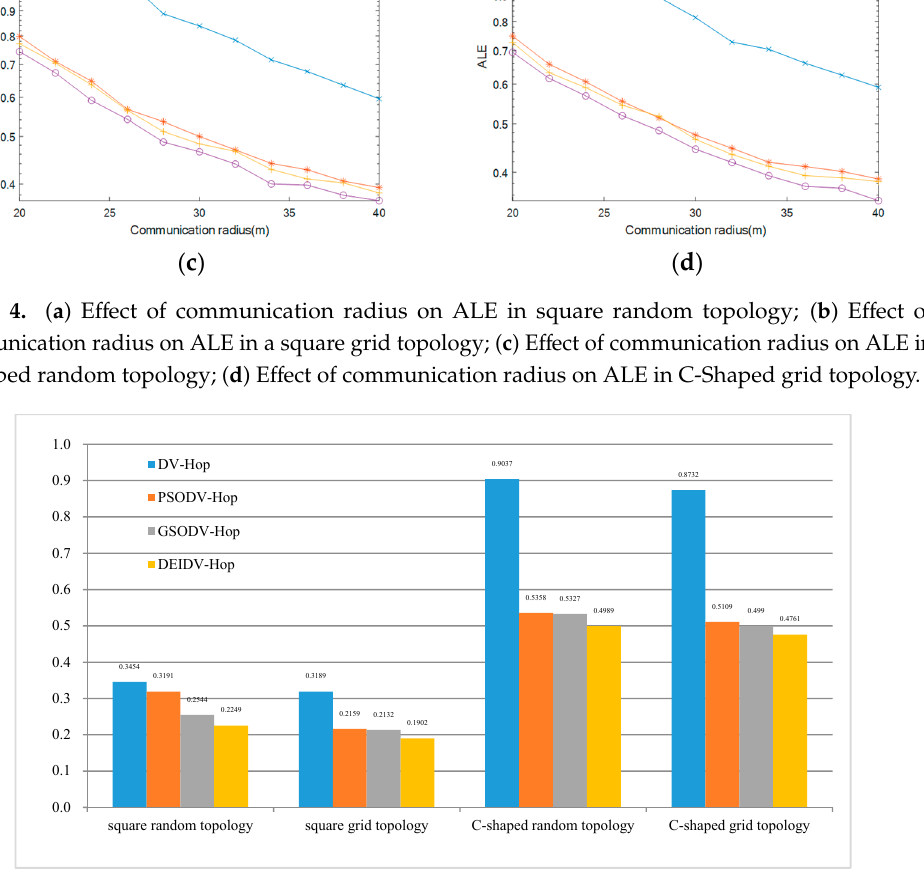
Figure 5. The average value of ALE for four topologies and algorithm.